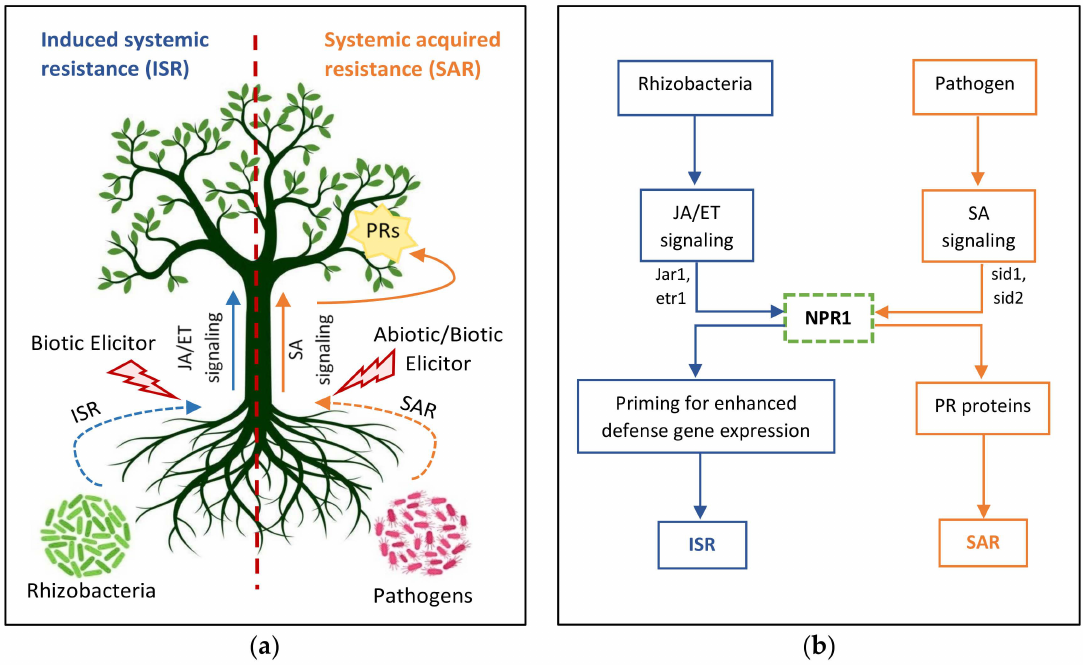
Figure 6. Schematic representation of defense priming: ( a ) a picture depicting induced systemic resistance (ISR), which is induced by plant growth-promoting rhizobacteria that provide resistance to biotic stresses, and systemic acquired resistance (SAR), which is induced by phytopathogens that provide resistance to biotic and abiotic stresses; ( b ) a flowchart showing signal transduction pathway of ISR that are followed by jasmonate (JA) and ethylene (ET) plant hormones, which are encoded by the jar1 and etr1 genes, respectively, whereas SAR is followed by salicylic acid (SA), which is encoded by the sid1 and sid2